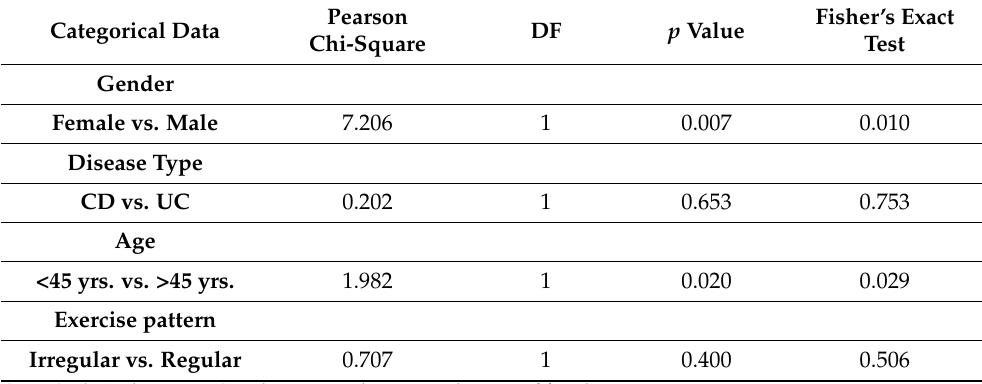
Table 4. Results of Chi-squared analysis for association with body image issues.